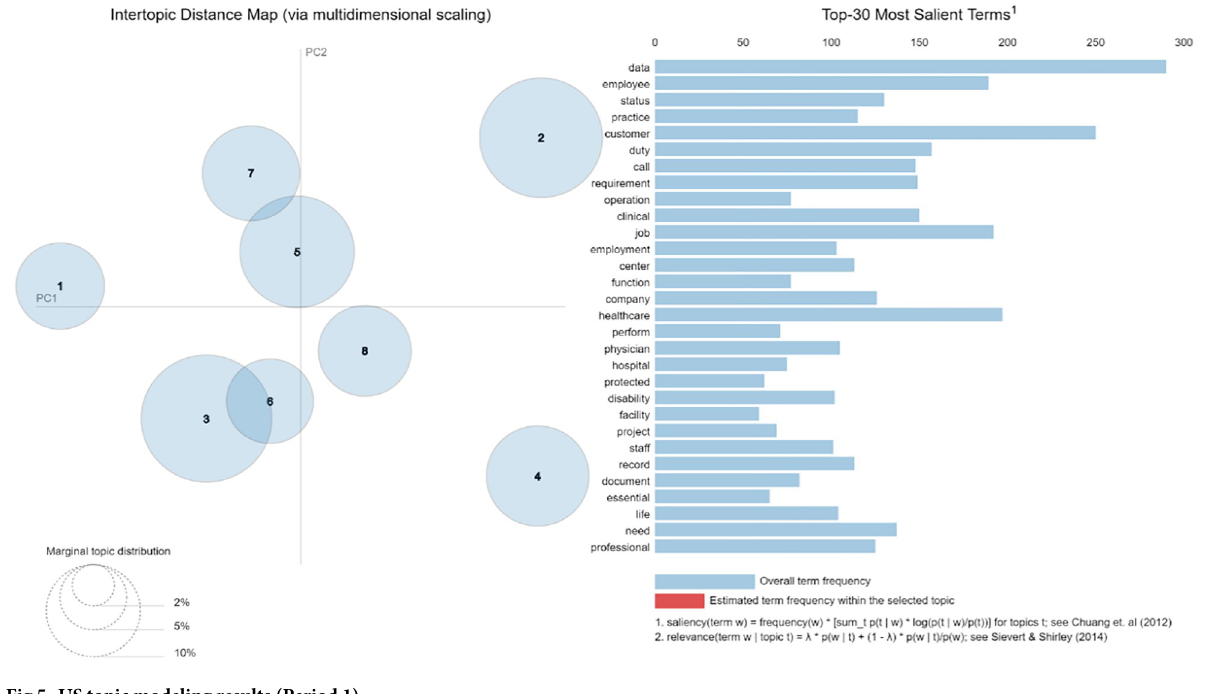
Fig 5. US topic modeling results (Period 1).